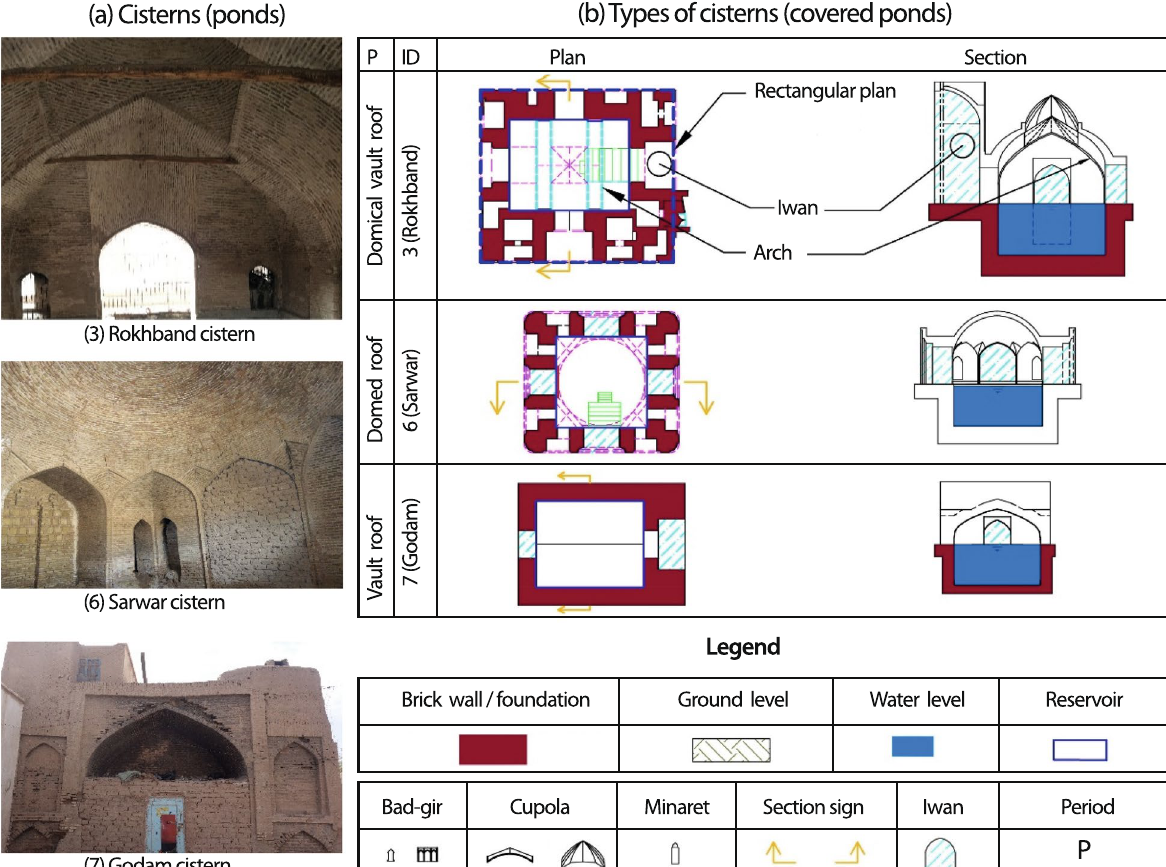
Fig. 3 Types of cisterns (Sources: a, photo by the authors 2021; b, from Asim and Ando